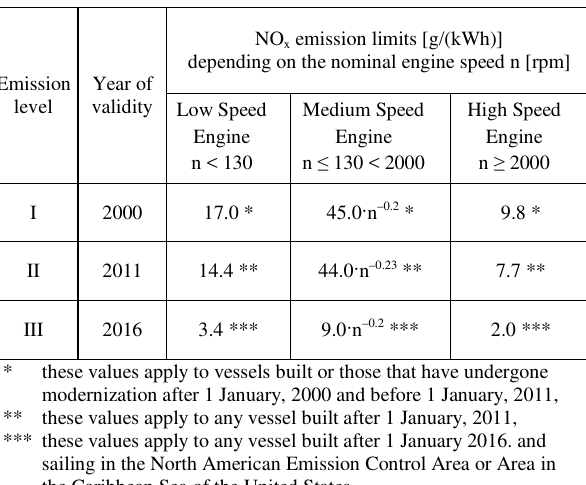
Table 1. The emission limit unit values for NO x for marine combustion- ignition engines with power over 130 kW according to Annex VI to